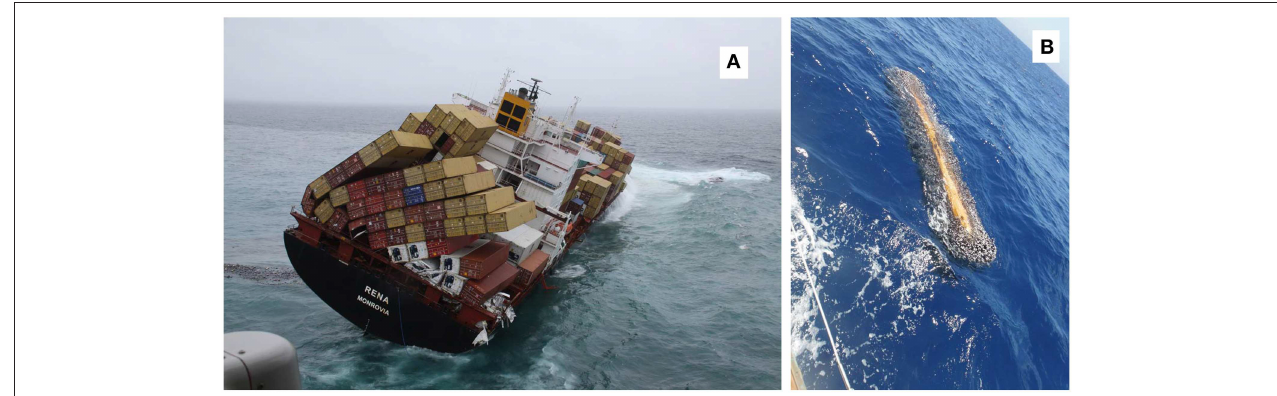
FIGURE 3 | (A) The MV Rena lost an estimated 900 containers when it ran aground and broke up off the coast of New Zealand in October 2011 (Photo courtesy of Maritime New Zealand). (B) Heavily fouled driftwood, floating in the North Pacific (courtesy of Randal Reeves) (Maximenko has permissions from Maritime New Zealand and Reeves to use the photos).